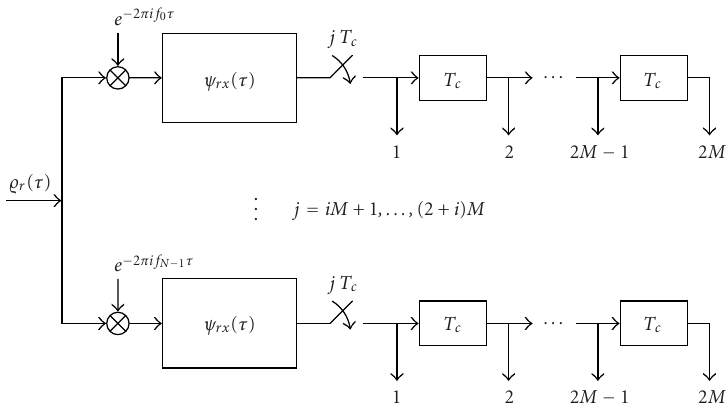
Figure 2: General A/D converter for an MC DS-CDMA